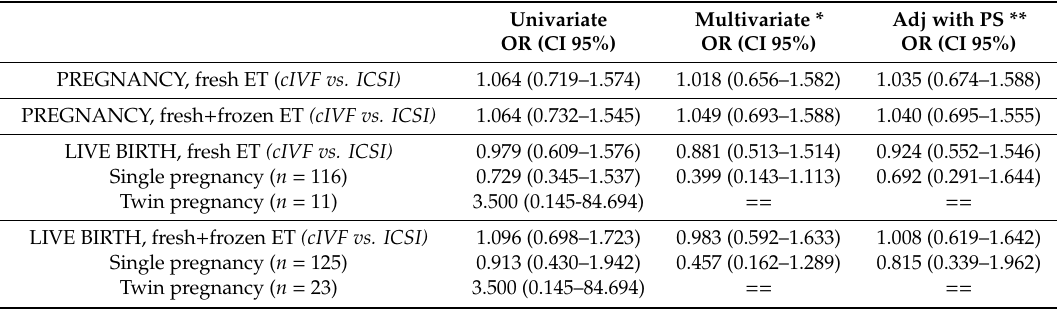
Table 3. Cycle outcome in the two study groups (univariate analysis, multivariate analysis and analysis after data correction and application of the PSM Propensity Score).